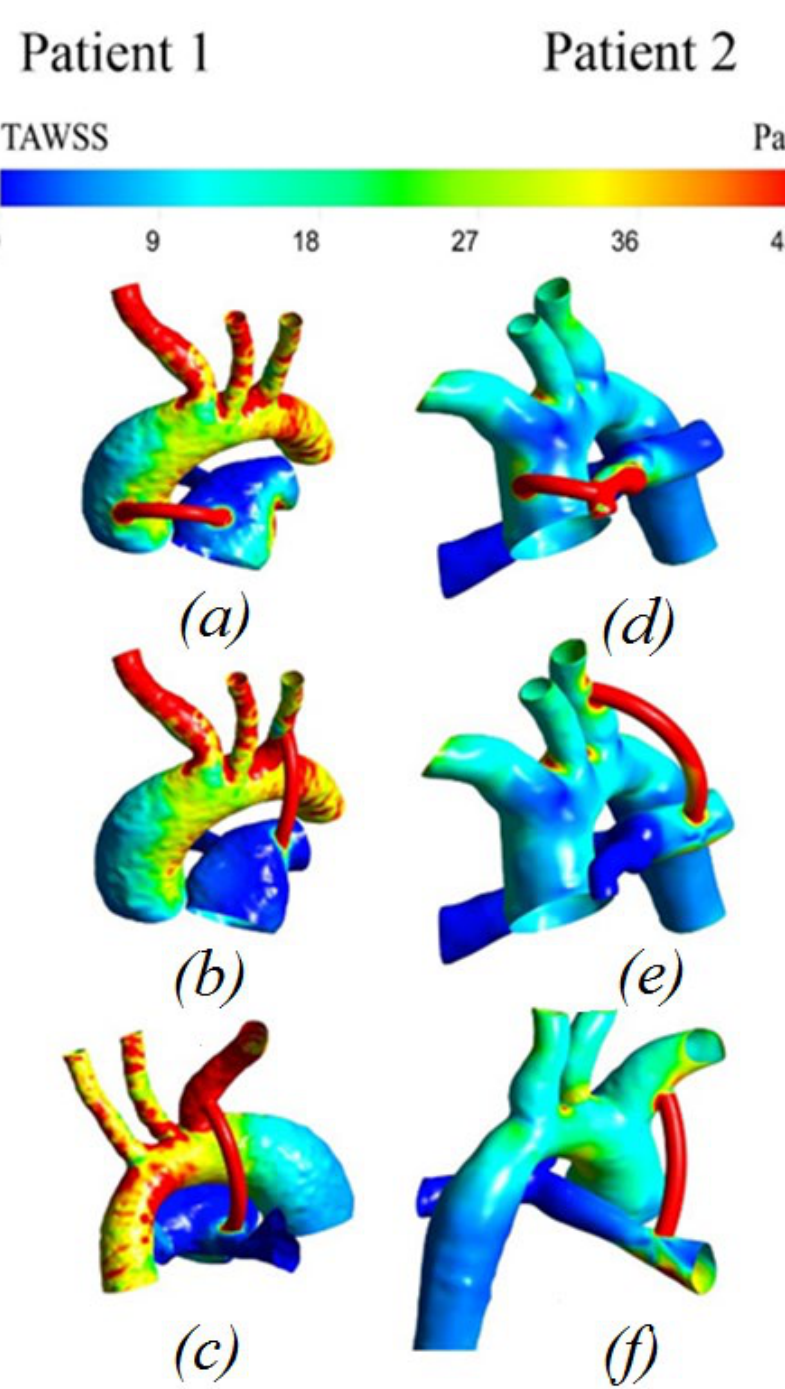
Figure 9. Distribution of time-averaged wall shear stress with anisotropic properties of the aorta and hyperelastic properties of the shunt: ( a , d ) central shunt; ( b , e ) right shunt; ( c , f ) left shunt.